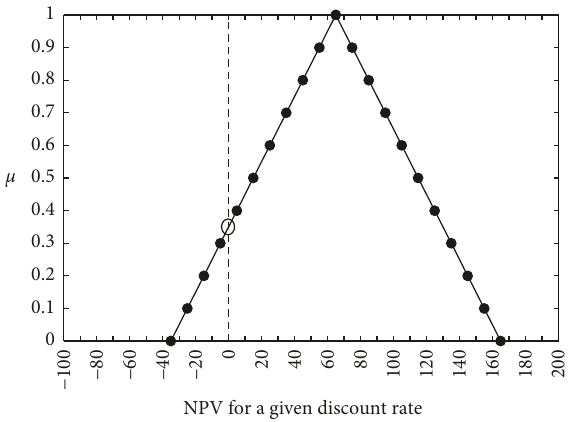
Figure 3: α -level sets of